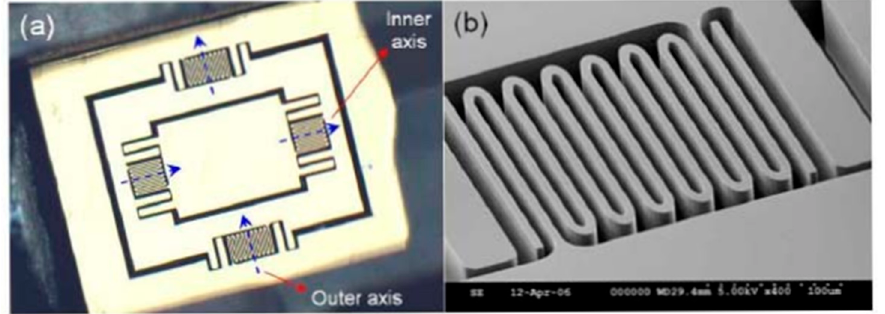
Figure 14. Photograph of electromagnetic micro-scanner in ( a ) and a SEM image of folded flexure hinges in ( b ) (Figures from [55]).